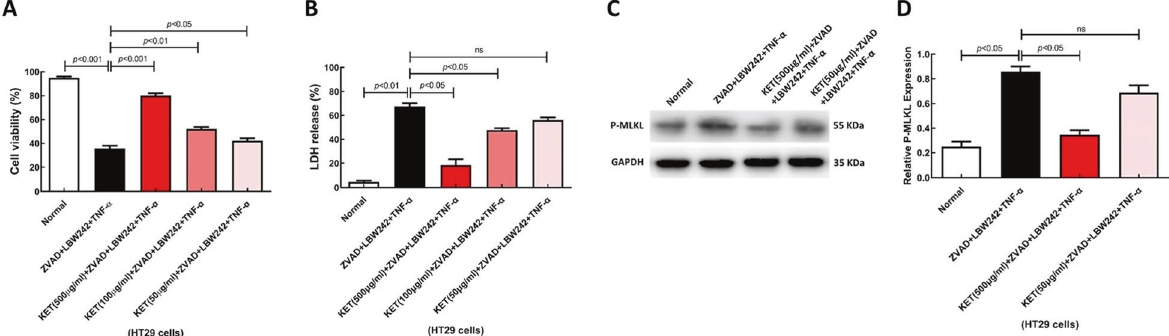
Fig. 4 The effect of ketamine on ZVAD/LBW242/TNF- α -induced the survival of HT-29 cells and suppressed the level of MLKL phosphorylation. HT-29 cells were treated with 10 µM Smac mimetic LBW242 and 20 µM ZVAD for 1 hour prior to stimulation with 20 ng/ml rhTNF in combination with different concentrations of ketamine for 24 h. A Cell viability via measuring ATP level in every group. B LDH release was used to determine the survival of HT-29 cells. C , D Immunoblot analysis of p-MLKL and GAPDH in HT-29 cells. Quantitative data are shown as the mean values of three independent experiments and the error bars are the mean ± SEM, ns no signi fi cant difference.